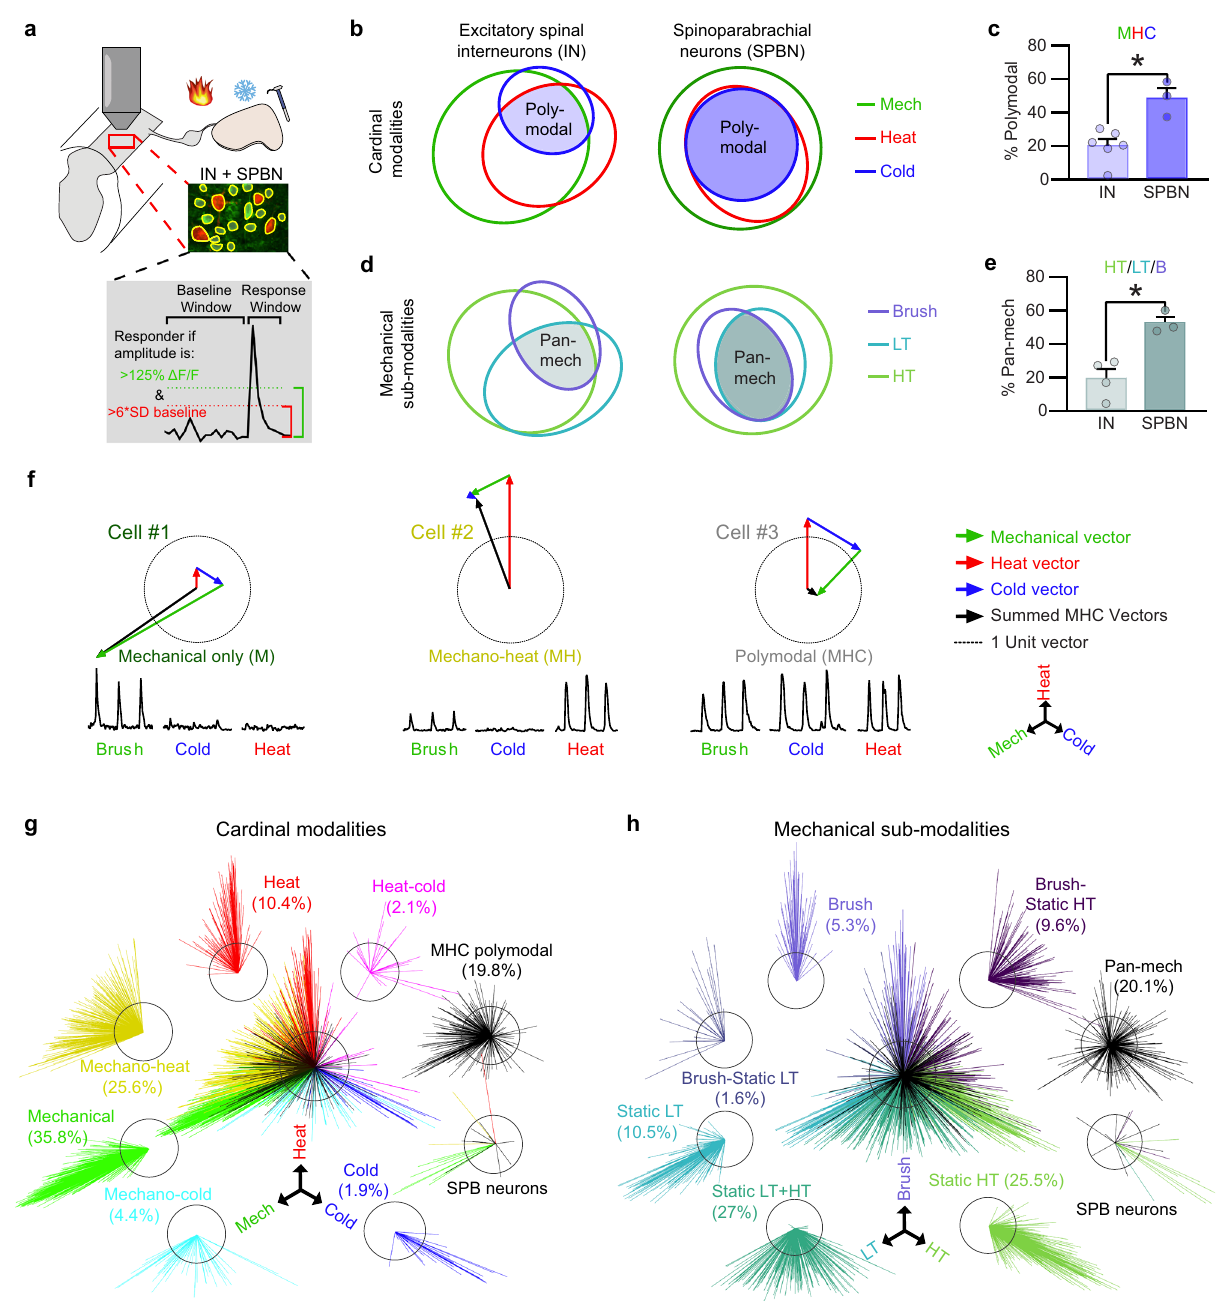
Fig.2|Polymodalityandtuningamongexcitatoryinterneuronsandprojection neurons. a Experimental design of imaging (top) and schematic of response thresholds (bottom). b Proportions of excitatory interneurons (IN, left) and SPB neurons (SPBN, right) that were responsive to cardinal modalities (cold, mechanical, heat). Shaded region represents the MHC polymodal population corresponding to c . c Percent of INs and SPBNs (averaged by animal) which displayedcardinalpolymodality.* P <0.05(two-tailedunpairedttest, P =0.0051). N =6 animals for interneurons N =3 animals for SPBNs. Data are presented as mean values±SEM. d , Proportions of INs (left) and SBPNs (right) that were responsivetothemechanicalsub-modalities:brush(purple),staticlowthreshold (LT, blue), or static high threshold (HT, green). Pan-mechanical sensitivity (pan- mech) indicates responsiveness to all tested types of mechanical stimuli. Shaded